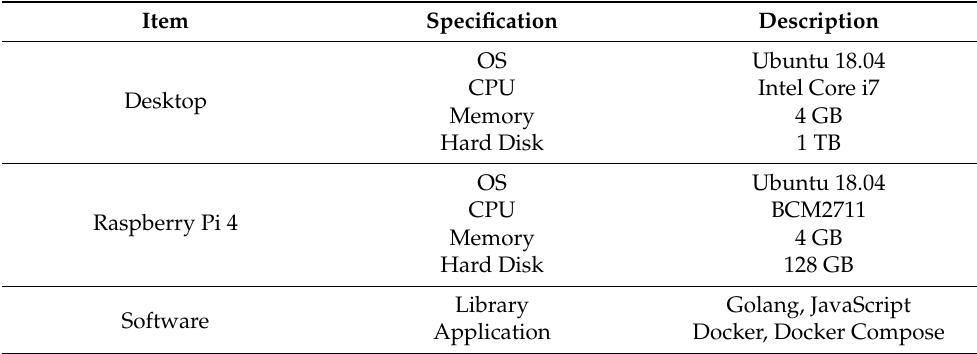
Table 1. Hardware and software specififications for edge computing network architecture.